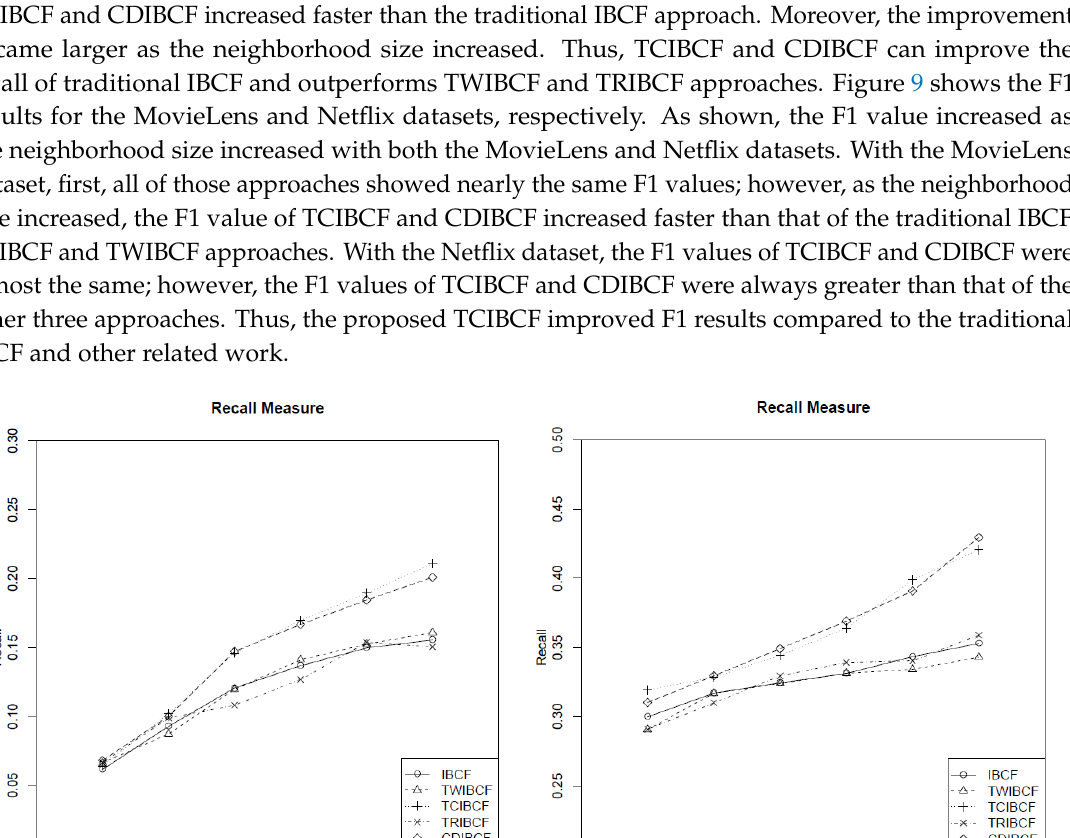
Figure 8. Recall results with MovieLens dataset ( a ) and Netflix dataset ( b ).